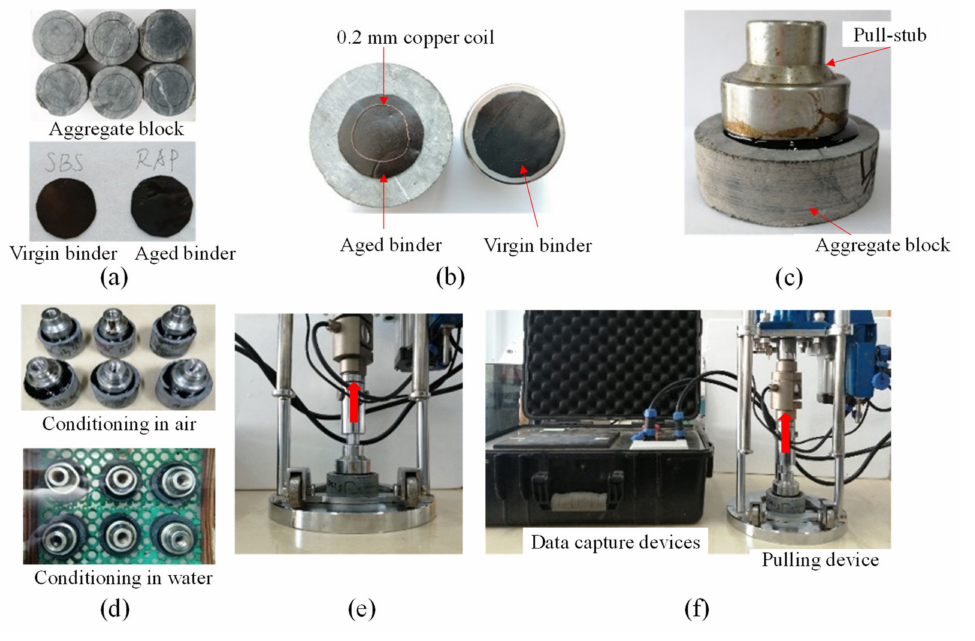
Figure 6. Main procedures for the pull-off test. ( a ) Samples of binder and aggregate; ( b ) Placement of binder sample; ( c ) The sample of binder-aggregate system; ( d ) Sample conditioning; ( e ) Sample installation; ( f ) The testing process. Table 3. Test parameters and pretreatment methods for the